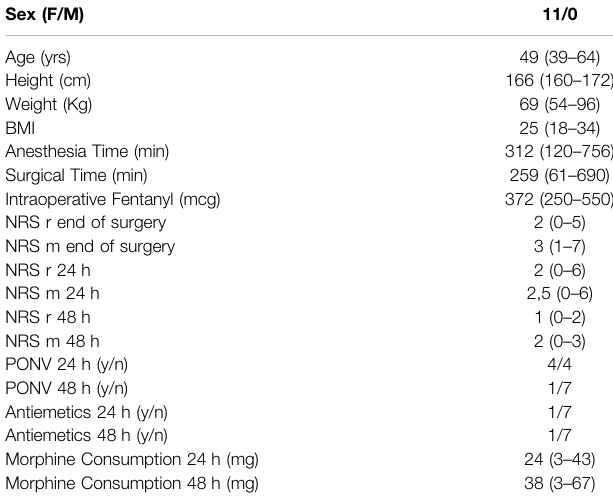
TABLE 2 | Anthropometrics and Clinical data related to the study